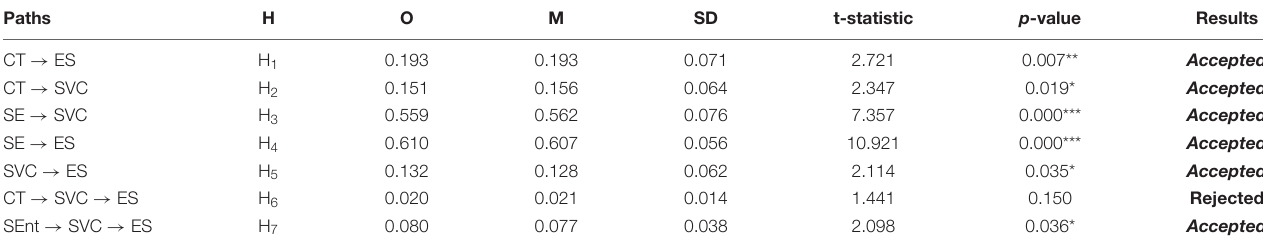
TABLE 7 | Direct effects and hypotheses testing.